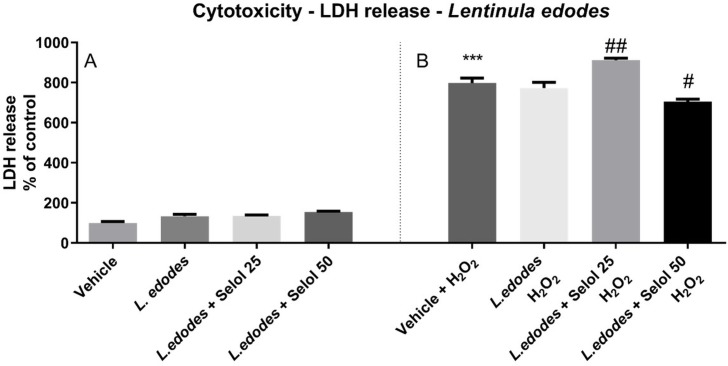
The effect of L. edodes extract with and without selenitetriglyceride supplementation on (A) the basal and (B) H2O2-induced release of lactate dehydrogenase (LDH) in SH-SY5Y human neuroblastoma cell line. Results are shown as the percentage of control cells not exposed to the extract of L. edodes and H2O2. The results are expressed as mean ± standard error of mean. The significance of differences between the means was evaluated using the Bonferroni post-hoc test followed by a one-way analysis of variance (selenitetriglicerides 25 –addition of 25 mg of Se(IV)/L of medium; selenitetriglicerides 50 –addition of 50 mg of Se(IV)/L of medium); ***P<0.001 versus control cells exposed to vehicle (1:10 ethanol/H2O); #P<0.05; ##P<0.005 versus cells exposed to vehicle + H2O2 alone; n = 12).